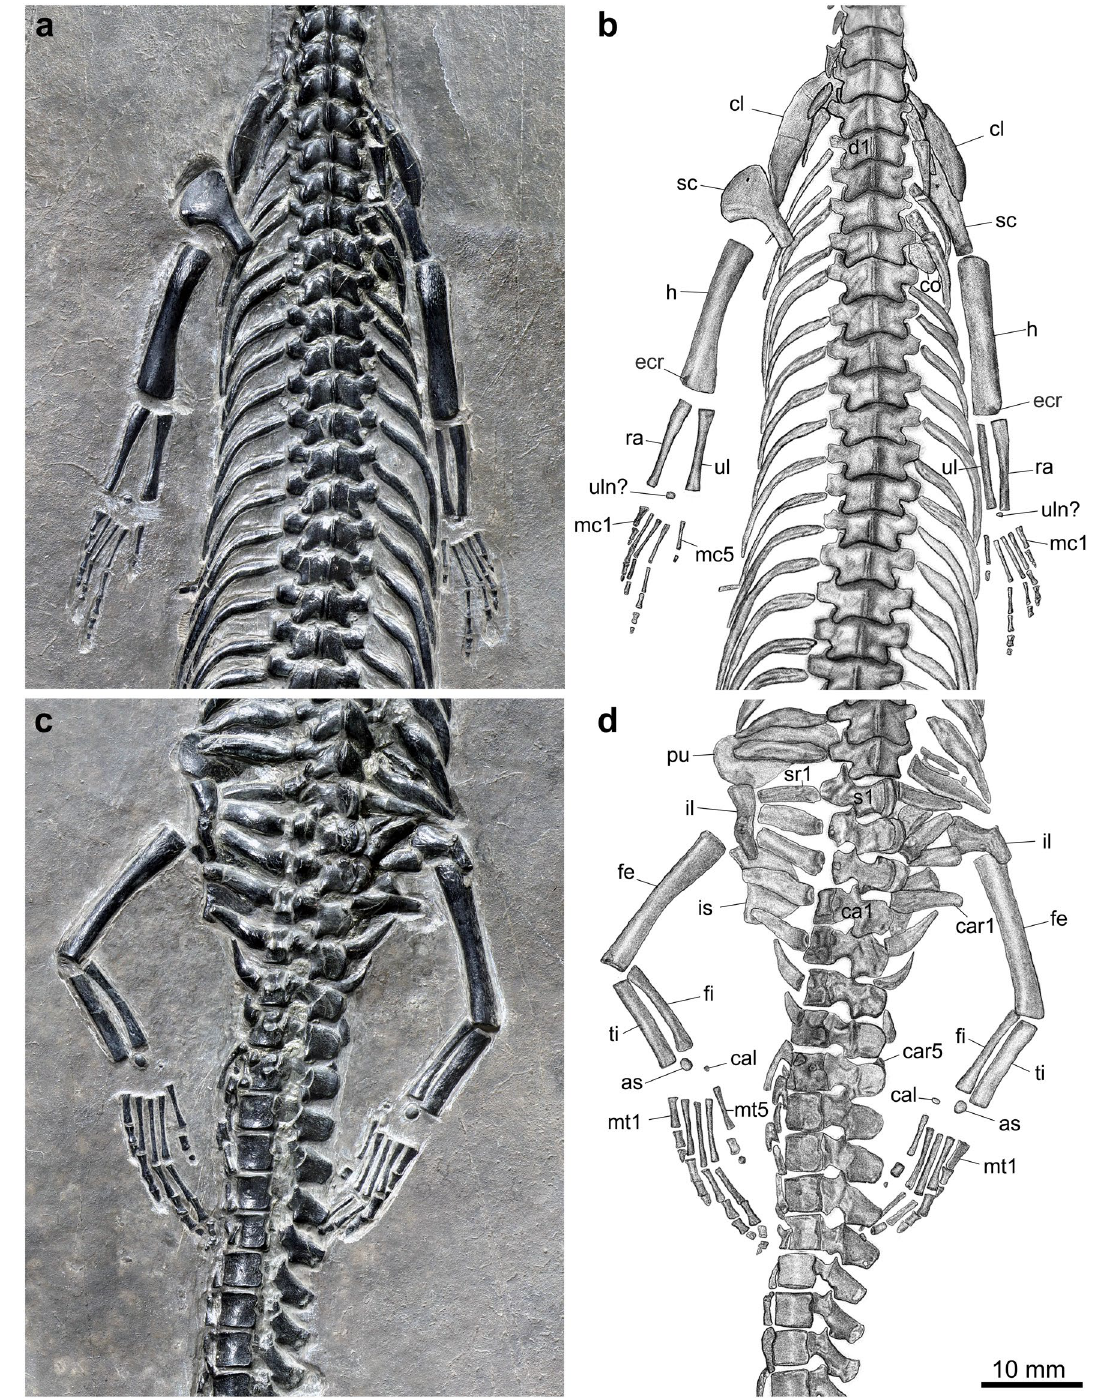
Figure 4. Girdles, limbs and vertebrae of Honghesaurus longicaudalis gen. et sp. nov., IVPP V30380. Photo ( a ) and line-drawing ( b ) of pectoral girdle, forelimbs and anterior dorsal vertebrae. Photo ( c ) and line-drawing ( d ) of pelvic girdle, hind limbs and posterior vertebrae. as, astragalus; ca, caudal vertebra; cal, calcaneum; car, caudal rib; cl, clavicle; co, coracoid; d, dorsal vertebra; ecr, ectepicondylar ridge; fe, femur; fi, fibula; h, humerus; il, ilium; is, ischium; mc, metacarpal; mt, metatarsal; pu, pubis; ra, radius; s, sacral vertebra; sc, scapula; sr, sacral rib; ti, tibia; ul, ulna; uln,